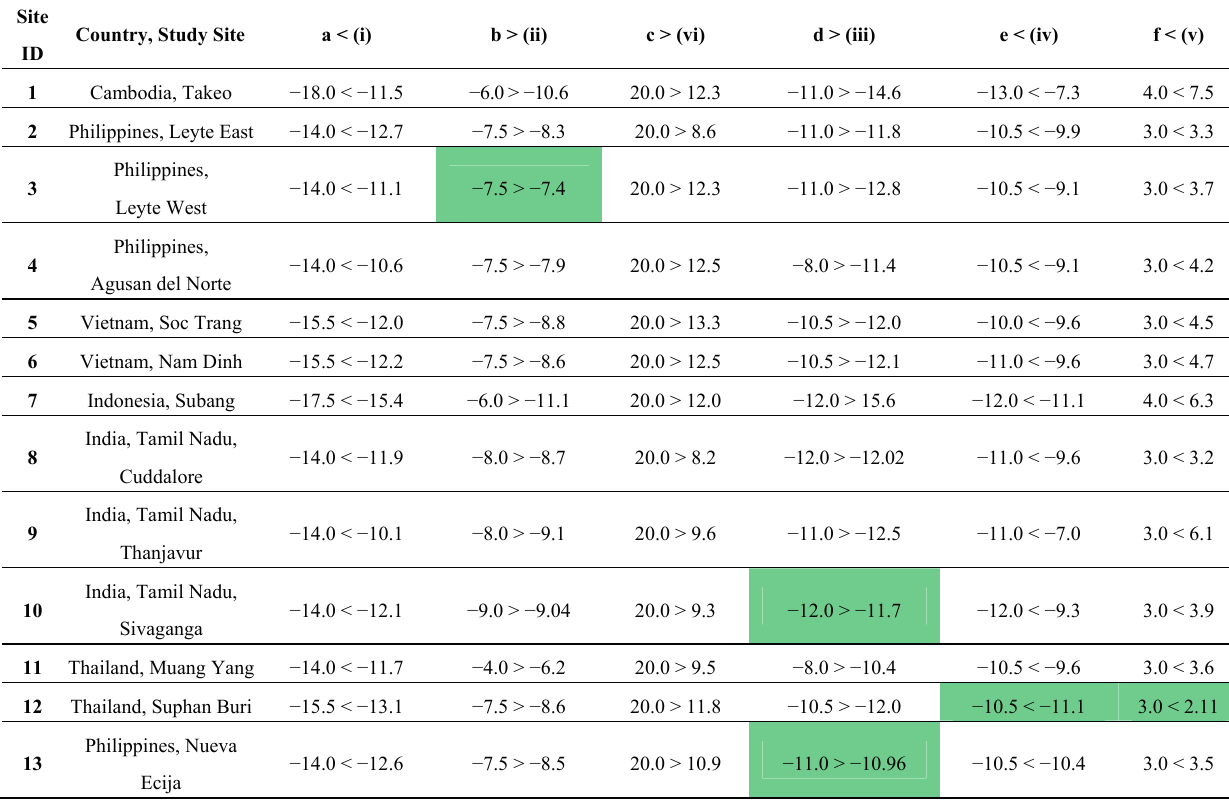
Table 4. Summary of the selected parameters (in dB) used for the rice classification at each site and the corresponding temporal feature values extracted from the field data. Shaded cells represent cases where the selected parameter did not follow the temporal feature